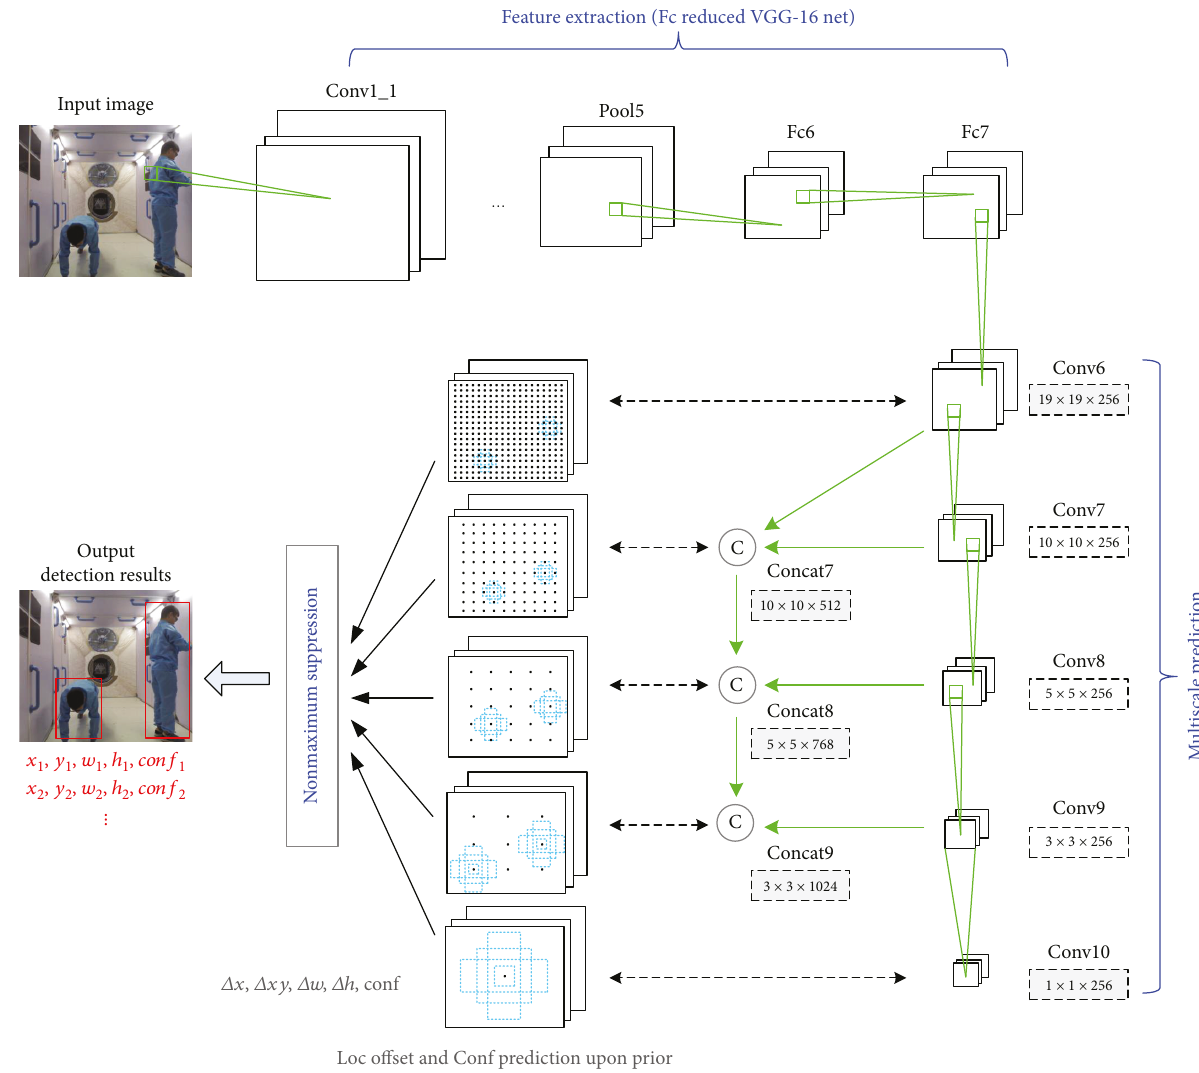
Figure 4: Deep convolutional neural network for astronaut